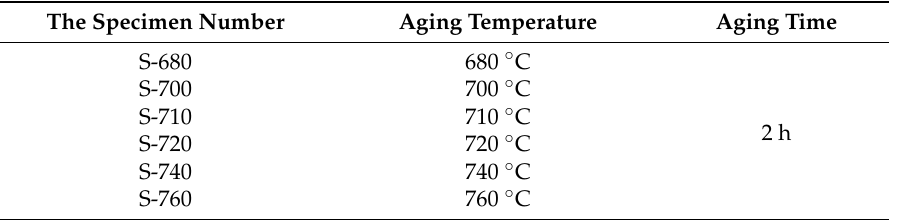
Table 2. Single-stage aging heat treatment process after solid solution heat treatment (SSHT).